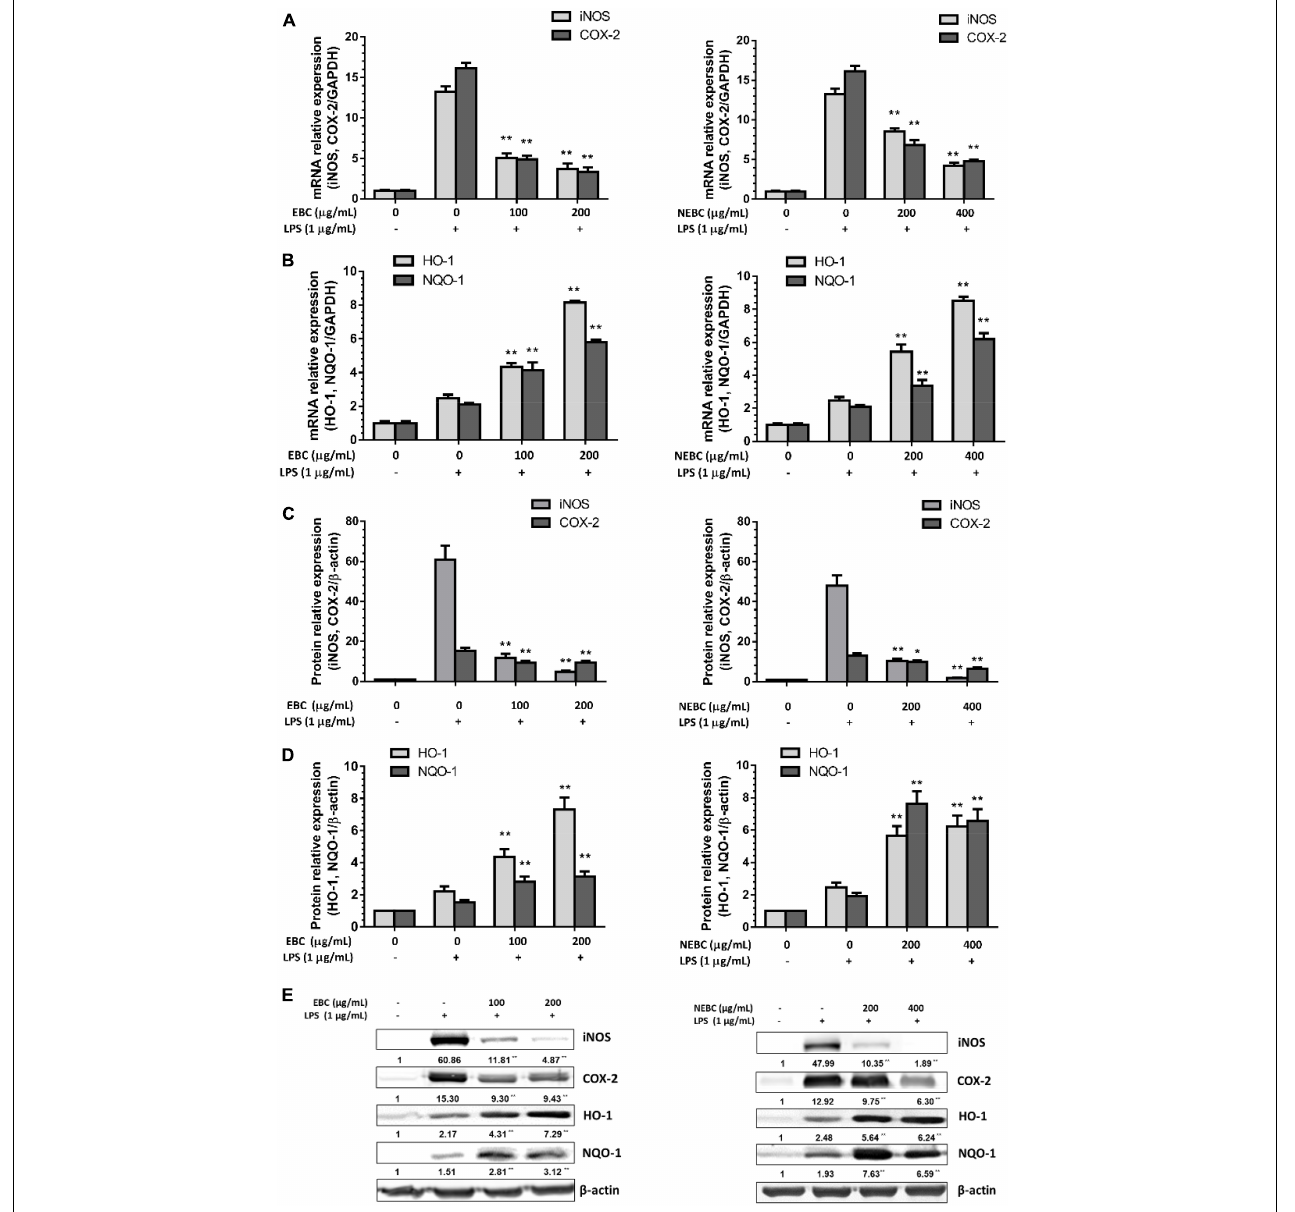
FIGURE 5 | Suppressive effects of EBCs and NEBCs on mRNA (A) expression and protein (C) expression levels of iNOS and COX-2 in activated macrophages. Effects of EBCs and NEBCs on mRNA (B) and protein (D) expression levels of HO-1 and NQO-1 in activated macrophages. Representative image of immunoblotting for the effects of EBCs and NEBCs on protein expression levels of iNOS, COX-2, HO-1 and NQO-1 in activated macrophages (E) . * indicates ( P < 0.05) and ** indicates ( P < 0.01), when compared to the LPS group.